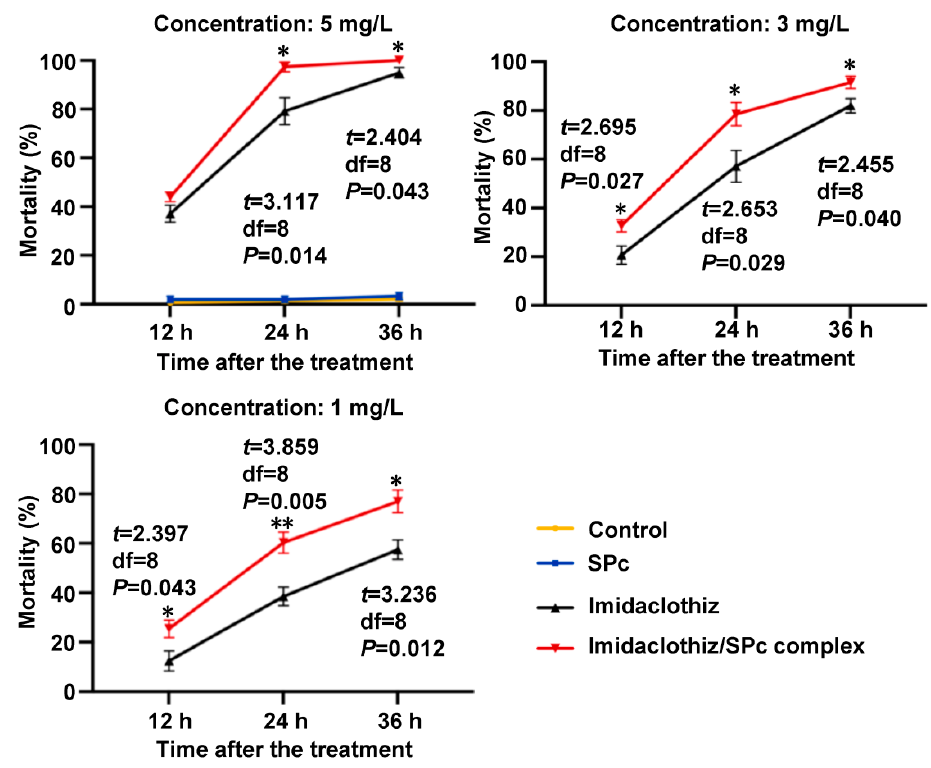
Figure 4. Bioactivity of imidaclothiz/SPc complex toward green peach aphids through root appli- cation. The pure imidaclothiz was mixed with SPc at the mass ratio of 1:5.1 according to the PLC. The highest concentrations of SPc and ddH 2 O were used as controls. Each treatment included ap- proximately 30 aphids, which was repeated 5 times. The “*” and “**” indicate significant differences (independent t test, p < 0.05 and p < 0.01).